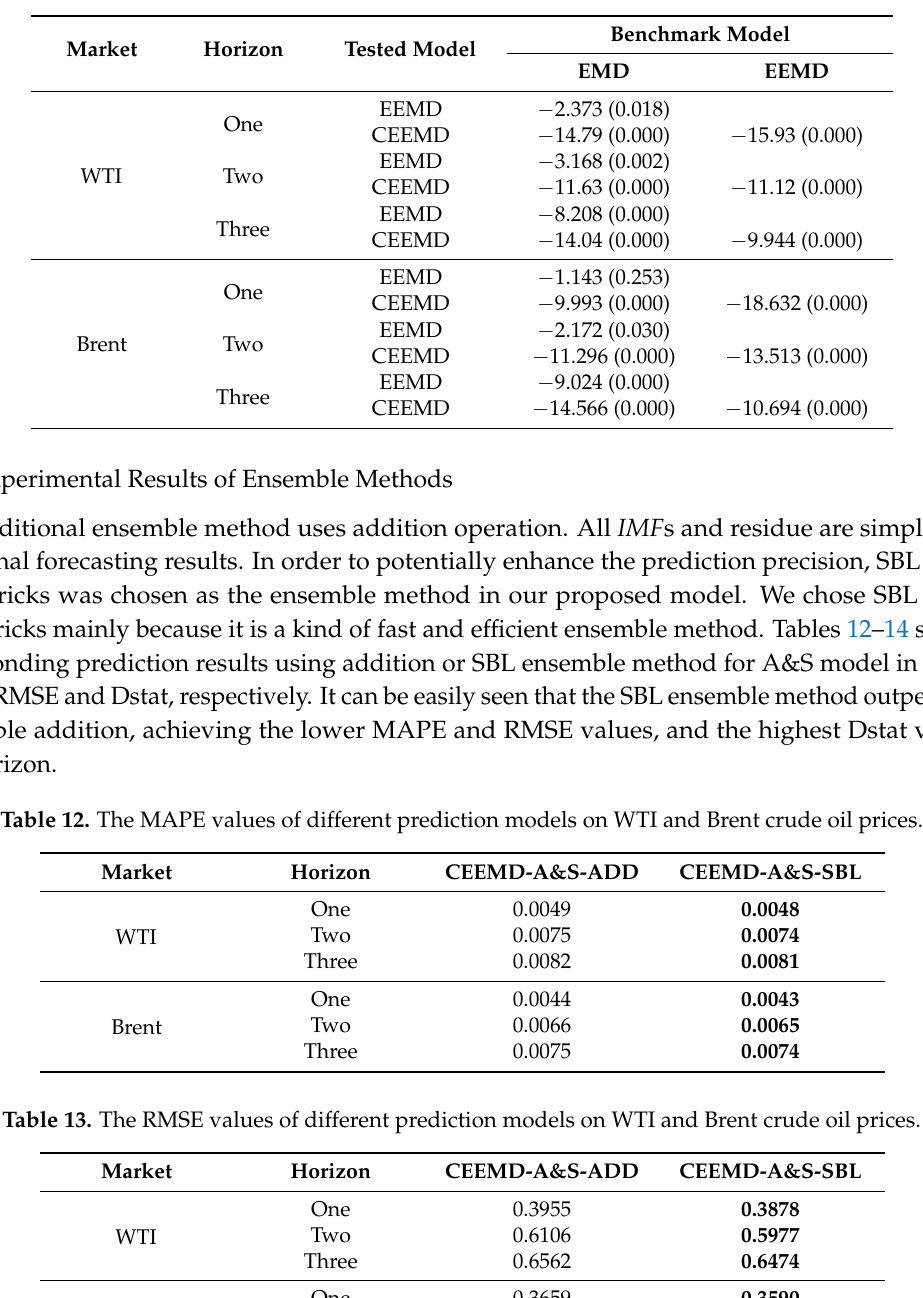
Table 11. The Diebold–Mariano (DM) test results on WTI and Brent crude oil prices.